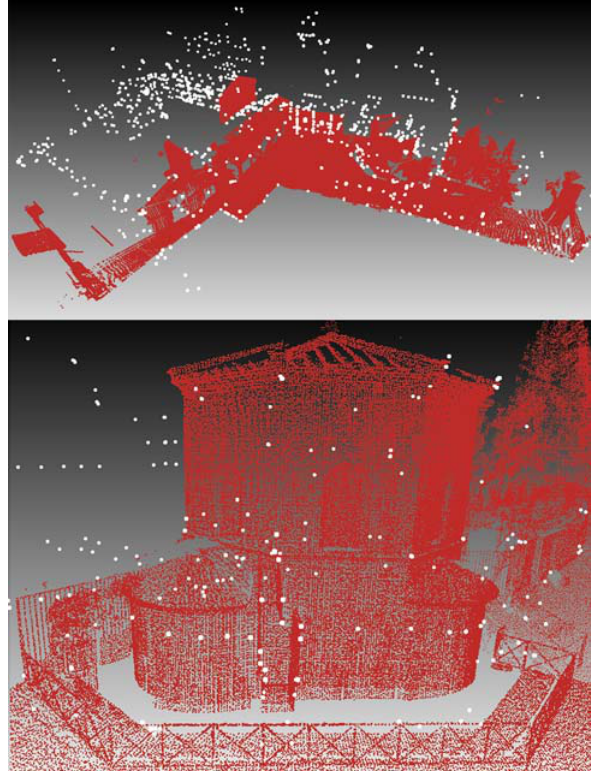
Figure 3. Alignment between the point cloud from laser scanner (red) and the point cloud from total station